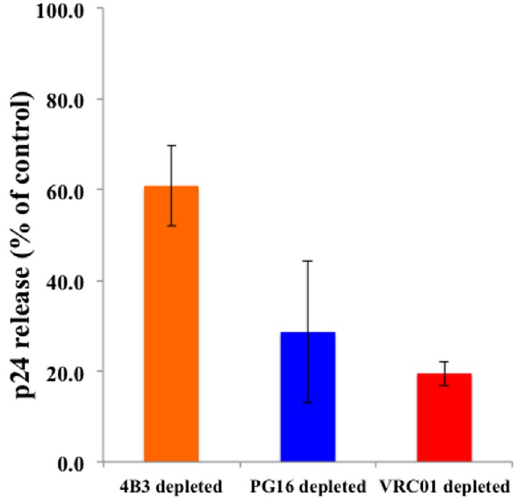
Figure 8. Infection of human lymphoid tissue ex vivo with MNP-depleted HIV preparations. Virions were captured with either 4B3-MNPs, PG16-MNPs, VRC01-MNPs or with isotype control (mouse IgG) MNPs. Captured virions were retained on magnetic columns, and the “flow-through” fractions, depleted of the captured virions, were used as inoculums. Infection of the tissues was evaluated from the amount of p24 released to the medium between day 6 and day 12 post-inoculation. Infection of the control flow-through fraction was considered to be 100%. Bars represent mean ± SEM of six experiments or five experiments. (In one tissue PG16-MNPs did not reduce infectivity and this experiment was